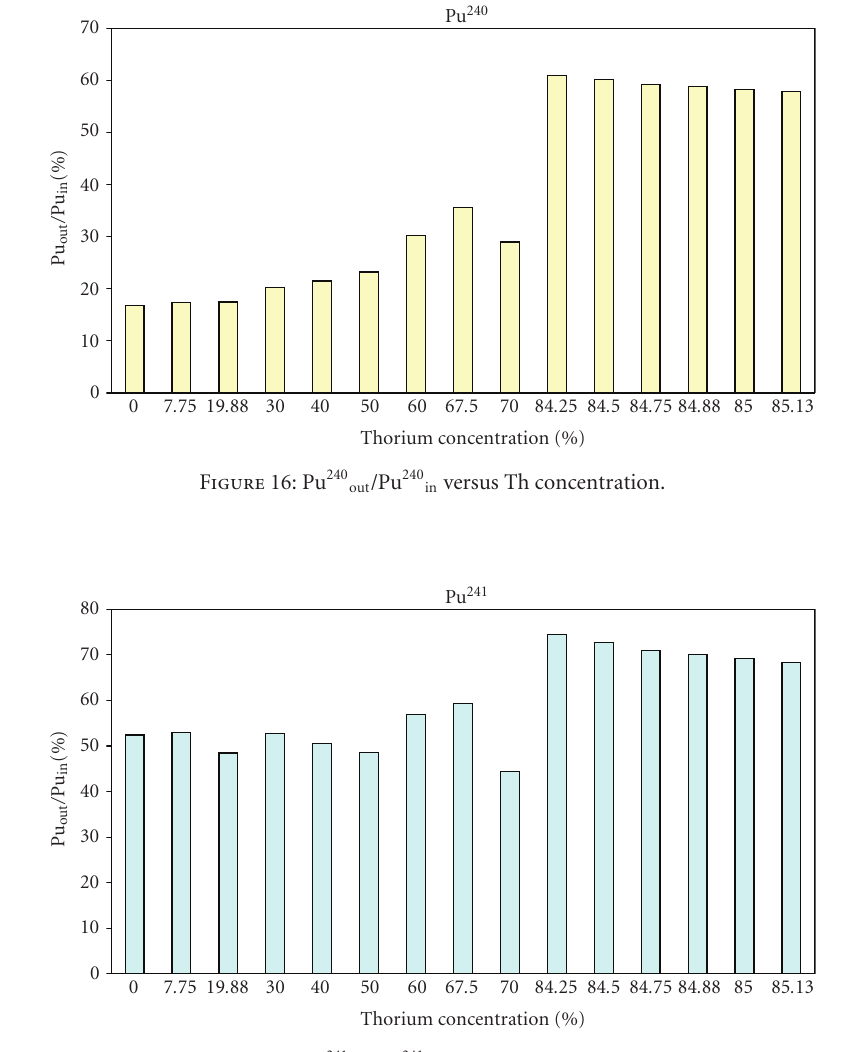
Figure 17: Pu 241 out /Pu 241 in versus Th